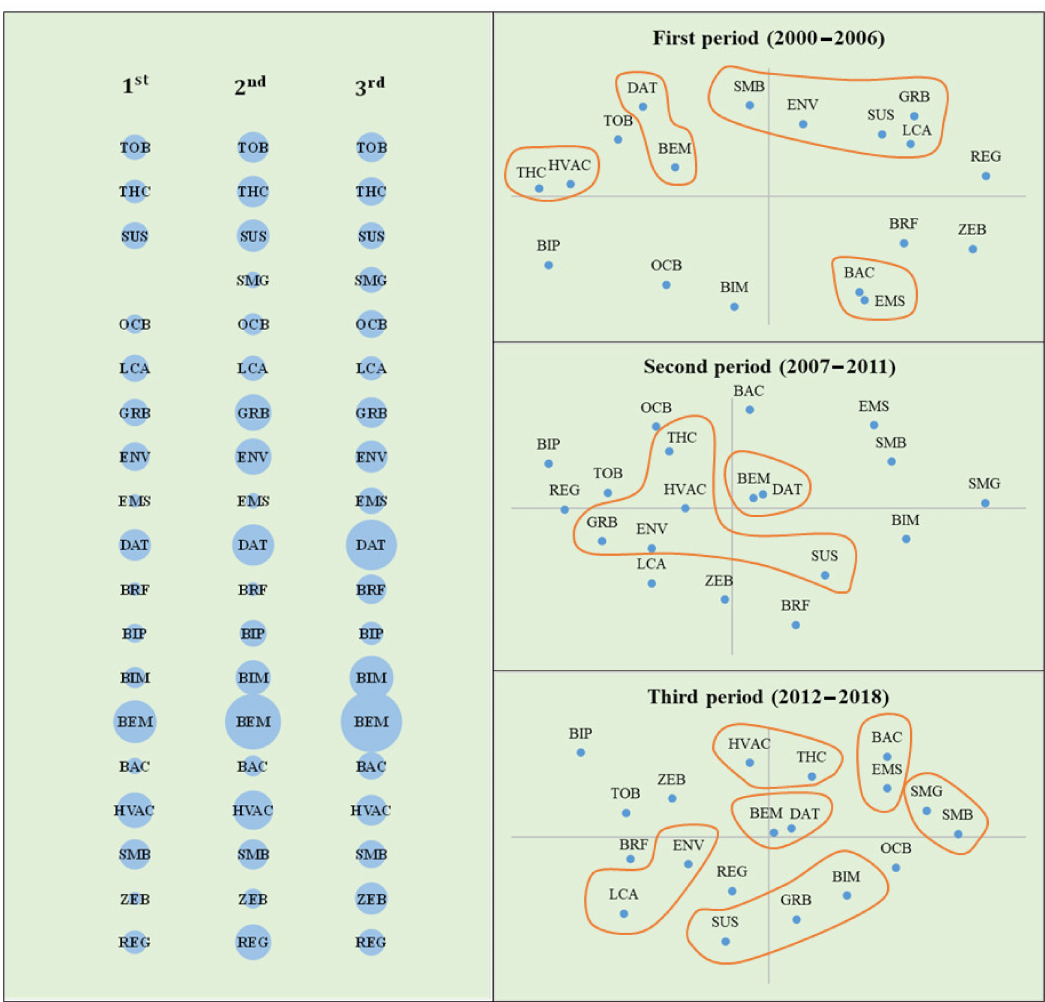
Figure 10. Evolution of the themes and relationship between them in each period (source: authors). The left side of Figure 10 shows the participation of the themes over the three evolu- tionary stages. On the right side, three plots represent the interrelationship matrix between the themes for each of the three evolutionary